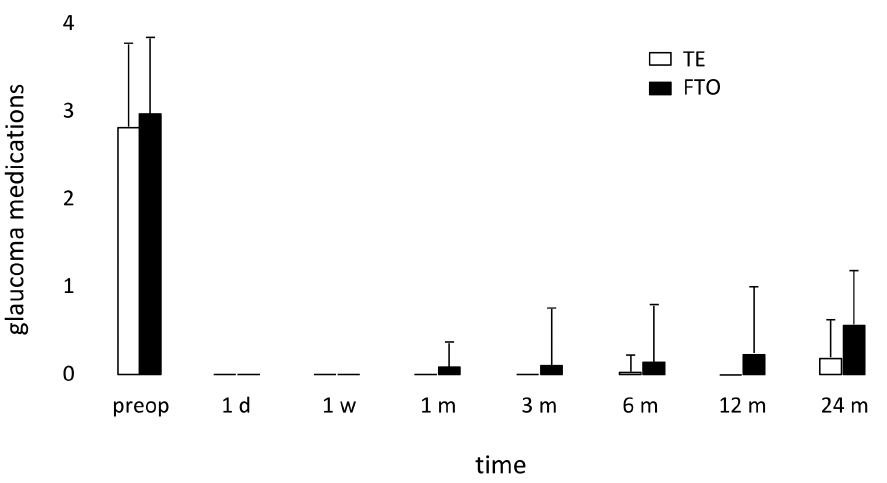
Figure 6. Preoperative versus postoperative glaucoma medications of both groups (mean±SD). FTO: filtering trabeculotomy; TE: